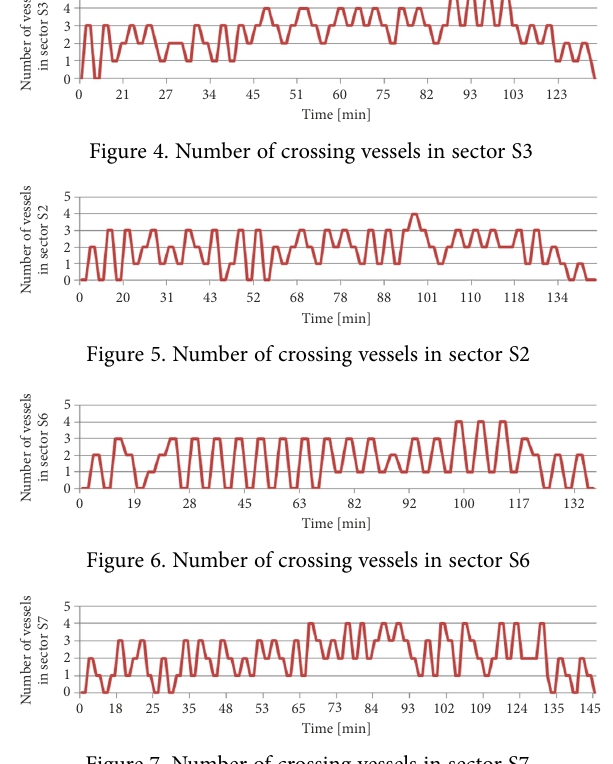
Figure 7. Number of crossing vessels in sector